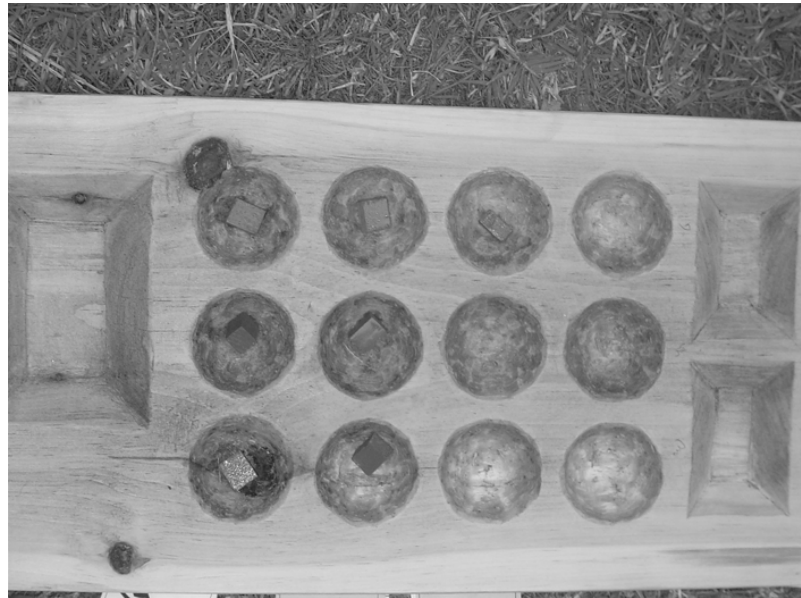
Fig. A3.1. Game board representing a village irrigation